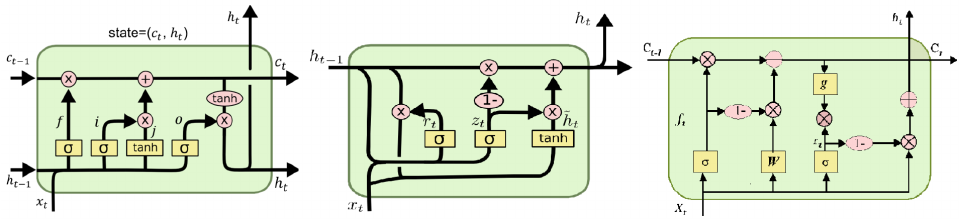
Figure 4. Internal structures of LSTM ( Left ), GRU ( Middle ), and SRU ( Right